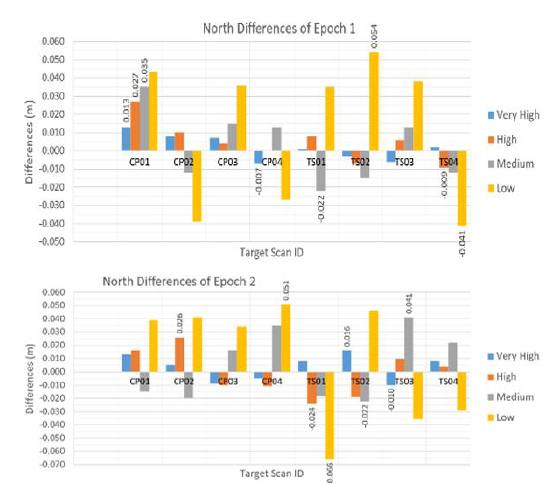
Figure 46. Northing coordinates differences between manually point picking and automatically computed by ScanMaster software (epoch 1 and 2)